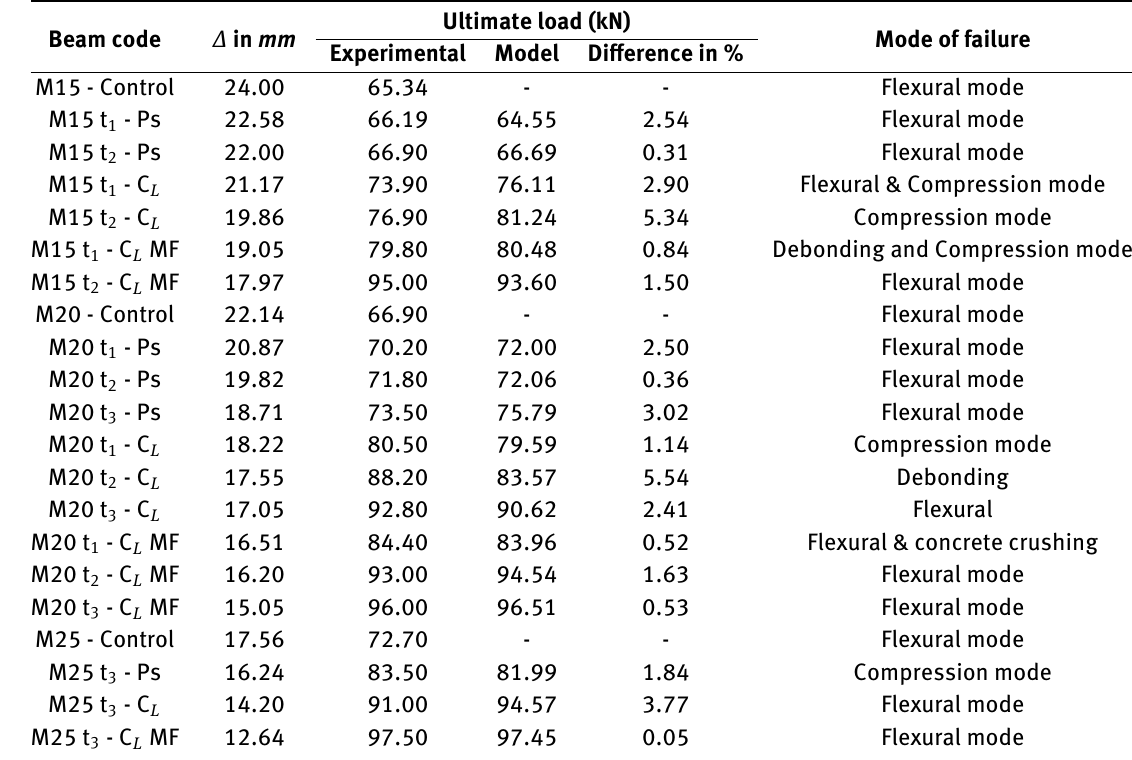
Table 2: Experimental and theoretical test results and specifications of beams